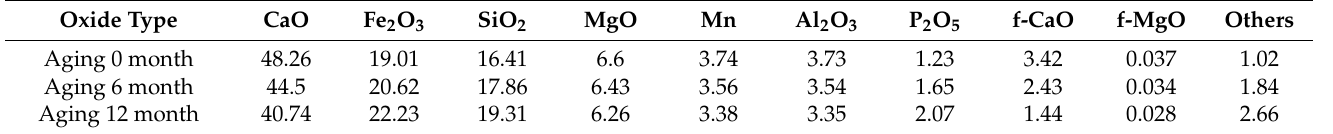
Figure 2. Multi-scale structure of steel slag by SEM. Table 2. Chemical composition of steel slag (%). Table 2. Chemical composition of steel slag (%).